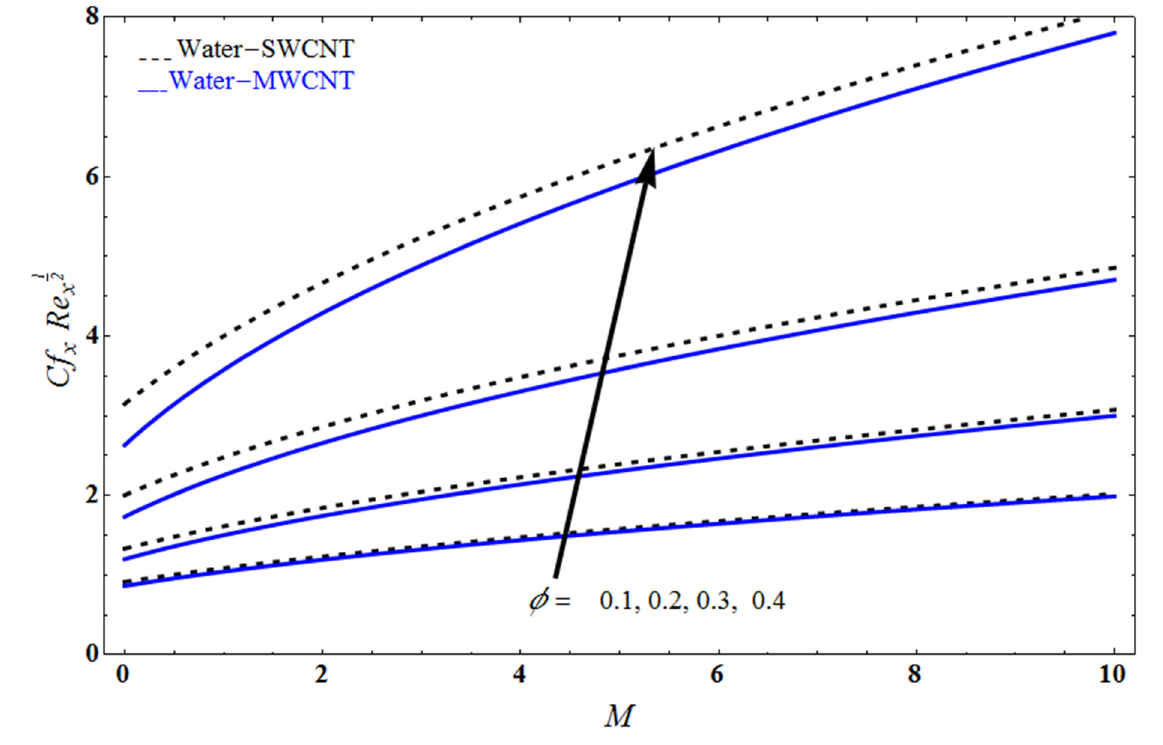
Figure 14. Impact of Cf x Re 1/2 on M for several values of φ , respectively. The Nusselt number versus elastic deformation parameter had an effect on the thermal radiation, and Eckert number, as shown in Figures 15 and 16. When the thermal radiation and Eckert number increased then the rate of heat transfer was observed to be enhanced.